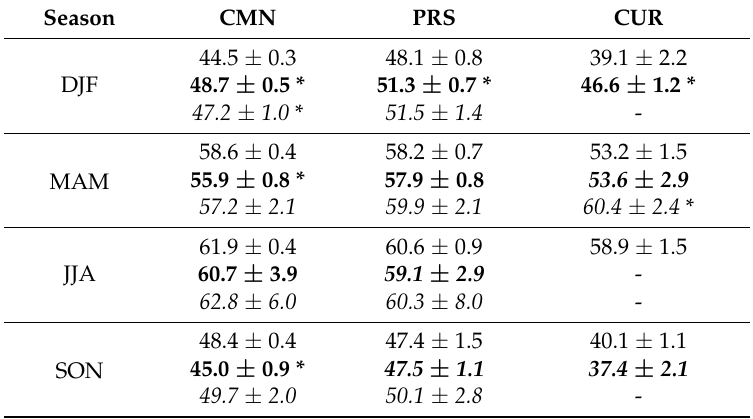
Table 4. Average near-surface O 3 values, together with 95% confidence level ( p < 0.05) for days without SI influence (plain), and with SI inputs as diagnosed by STEFLUX (bold). Italic denotes average values considering only days for which the RH daily averages were lower than 60%. Asterisks denote SI selections with statistically significant (at the 95% confidence level) average O 3 differences with respect to no-SI